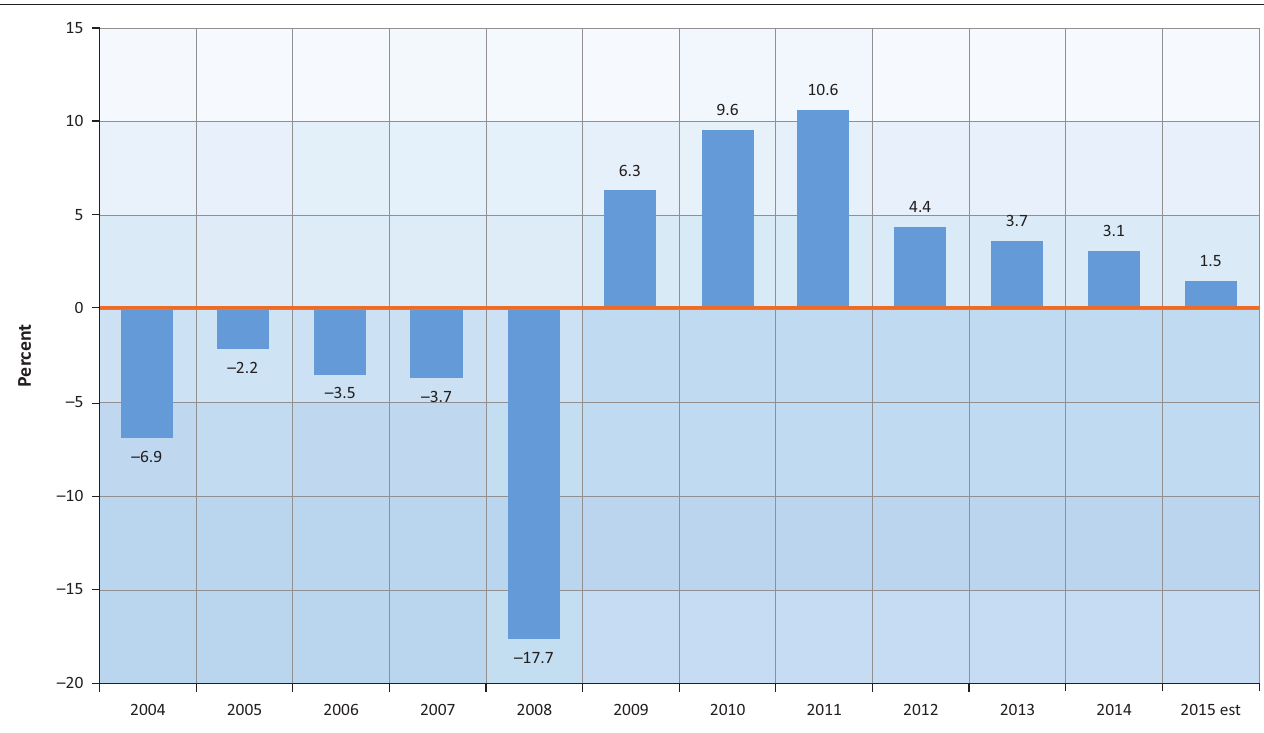
FIGURE 3 : Zimbabwe Annual gross domestic product growth